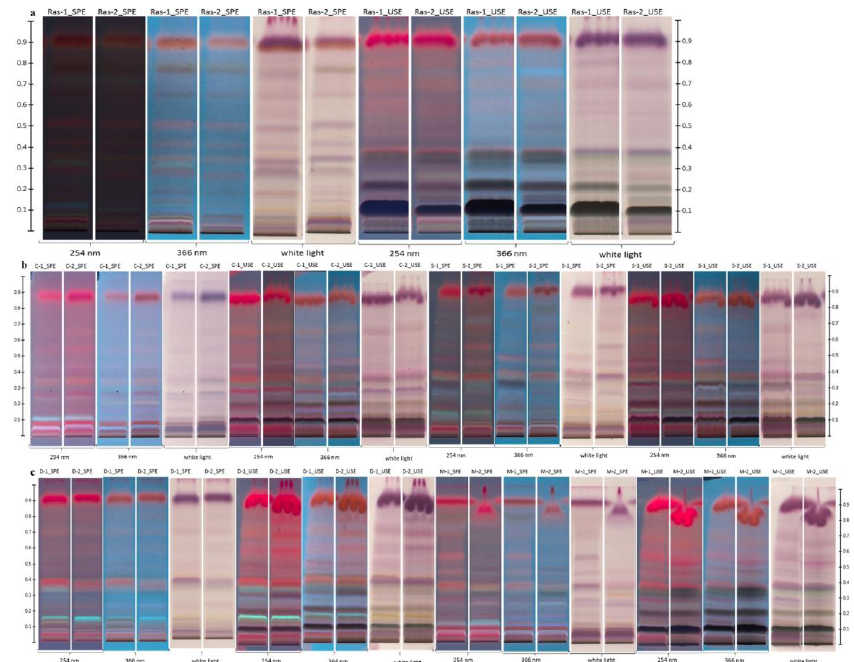
Figure 2. HPTLC fingerprints of honeys of different botanical origin after derivatisation (UAE— ultrasound assisted extraction, SPE—solid phase extraction visualised under white light, 254 nm and 366 nm; ( a ) Ras—raspberry honeys; ( b ) C—clover honeys; S—sweet yellow clover honeys; ( c ) D— dandelion honeys; M—milk thistle honeys).